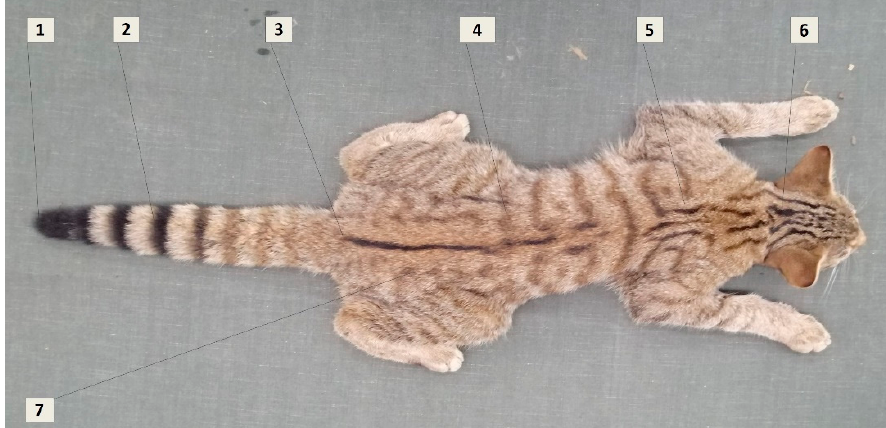
Figure 4. The seven key pelage characteristics of the European wildcat (1) Shape of tail tip: blunt (2) Distinctness of tail bands: Distinct—not fused or joined with dorsal line (3) Extent of dorsal line: stops at base of tail (4) Broken stripes on flanks and hindquarters: <25% broken (5) Stripes on shoulder: Two thick stripes (6) Stripes on nape: four thick stripes (7) Spots on flanks and hindquarters: none [33,34].